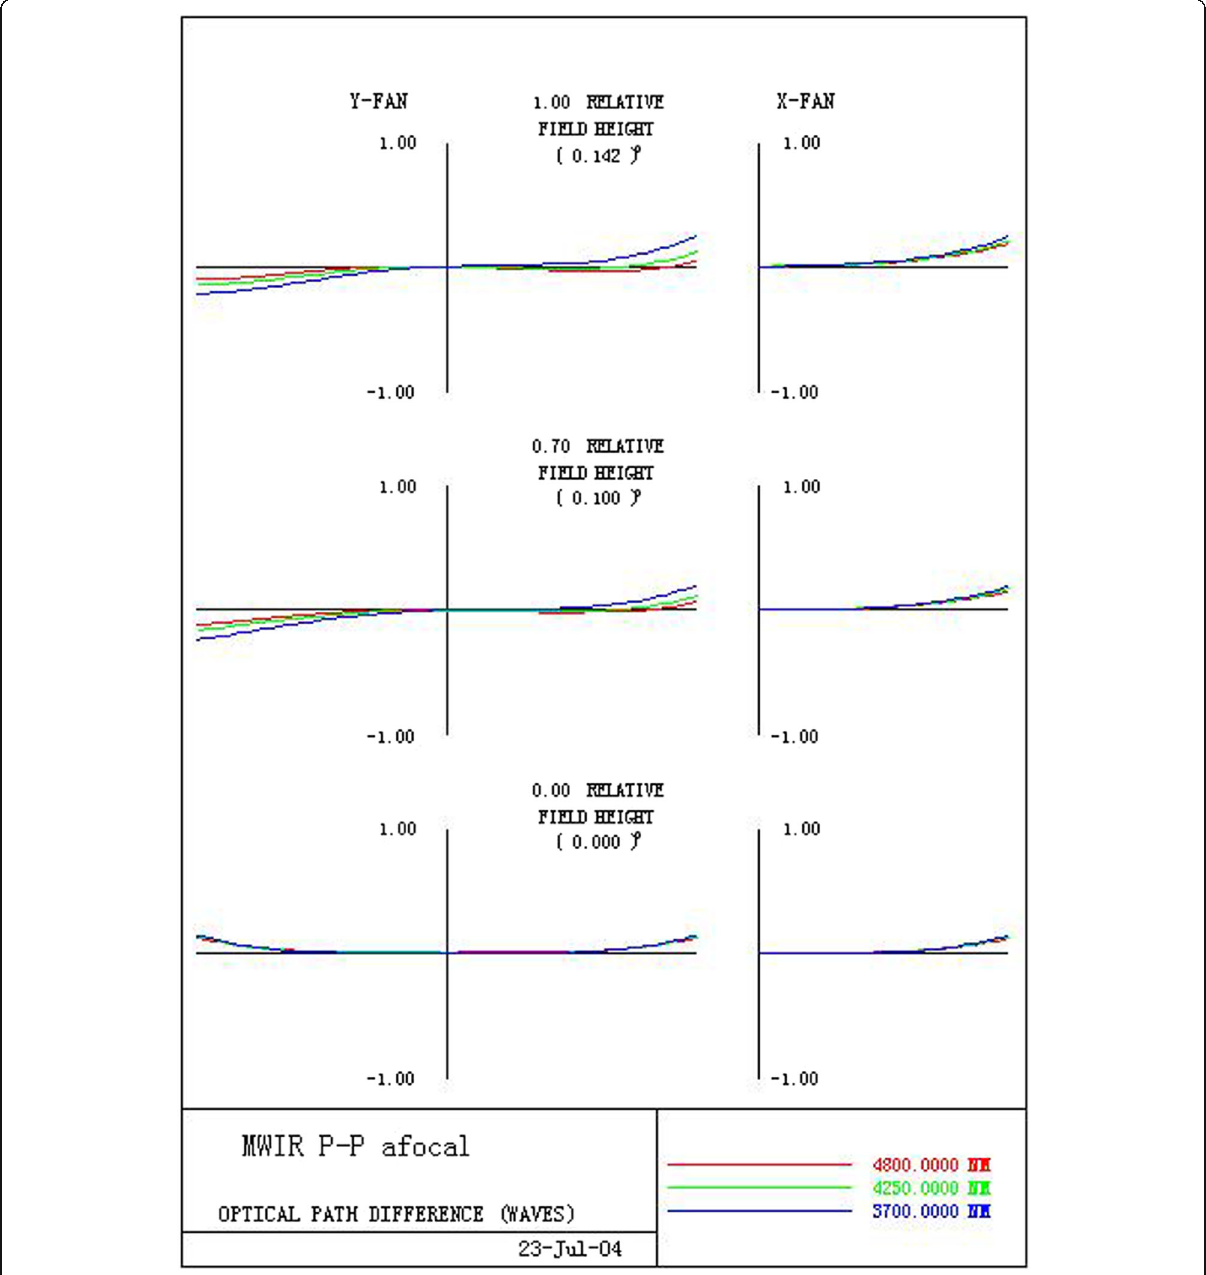
Fig. 4 System aberration curve